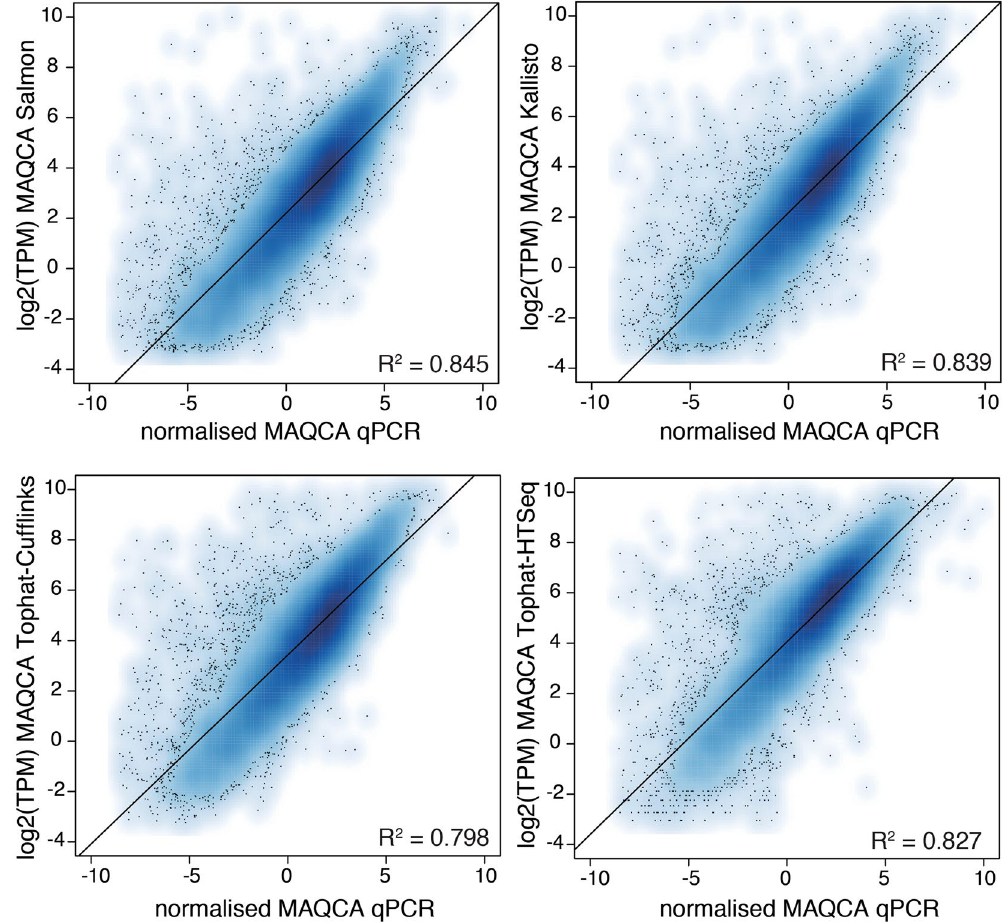
Figure 1. Gene expression correlation between RT-qPCR and RNA-seq data. The Pearson correlation coefficients and linear regression line are indicated. Results are based on RNA-seq data from dataset